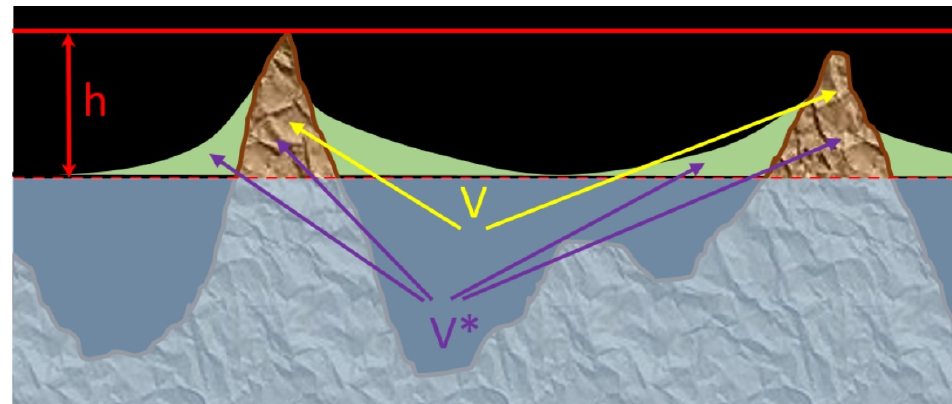
Figure 19. Relation between volume of deflected rubber and penetration depth for pavements SMA8 and APS.